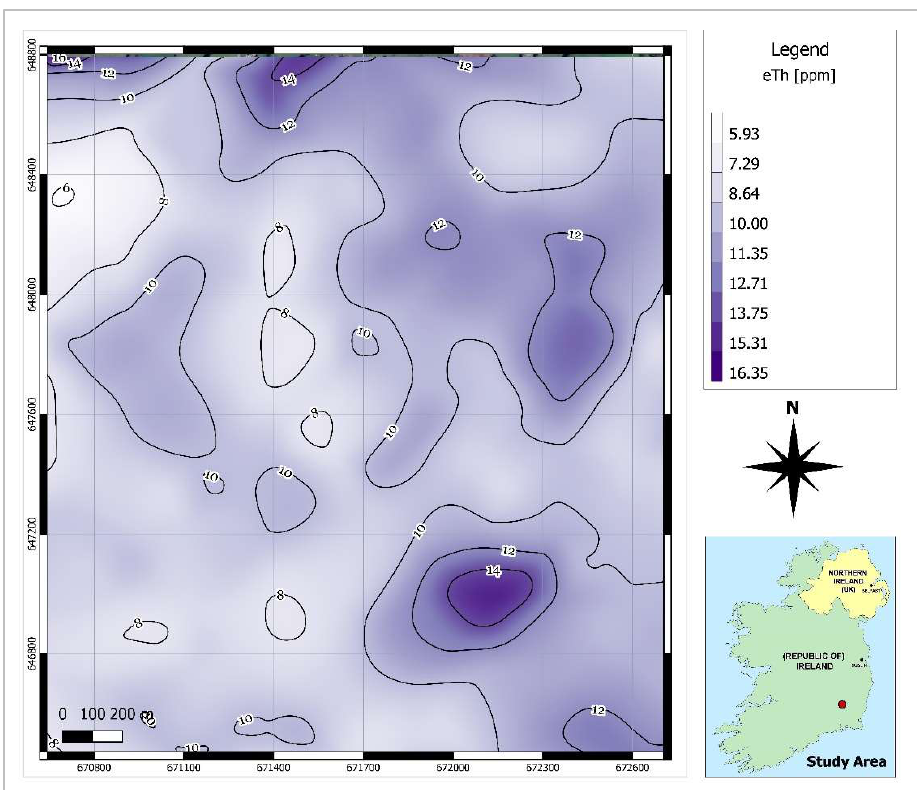
Figure 4. Contour map of equivalent thorium concentration (eTh).